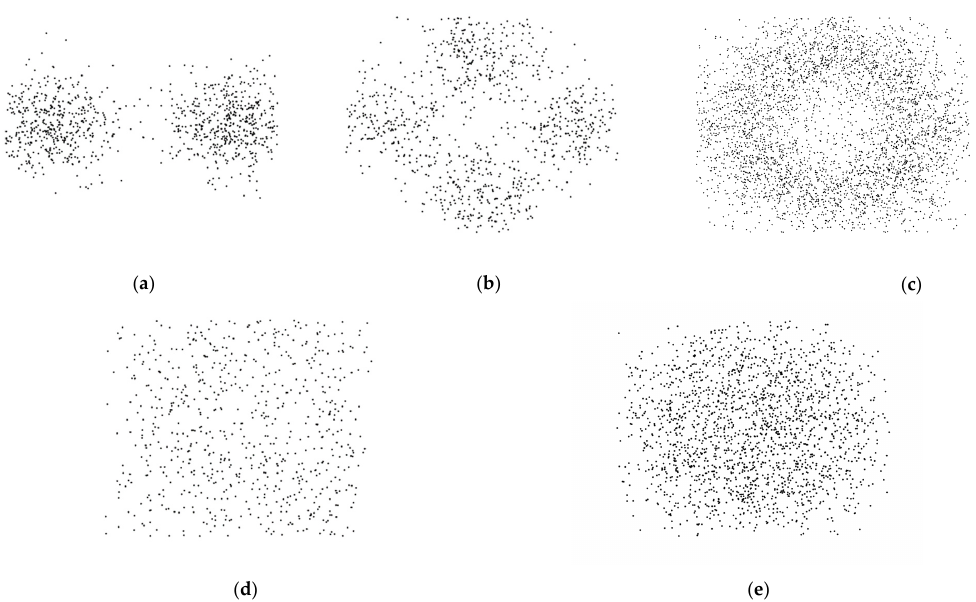
Figure 3. Signal Constellation Chart (SNR = 6 dB) ( a ) BPSK; ( b ) QPSK;( c ) 8PSK; ( d ) 16QAM; ( e ) 32QAM.